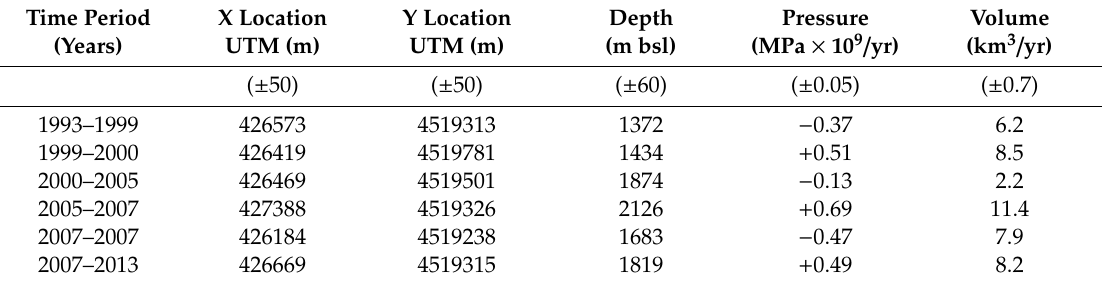
Table 2. Six time periods used for modeling expansion / contraction sources below Campi Flegrei Caldera and associated location, pressure, volume, and depth to the center of mass a [53].